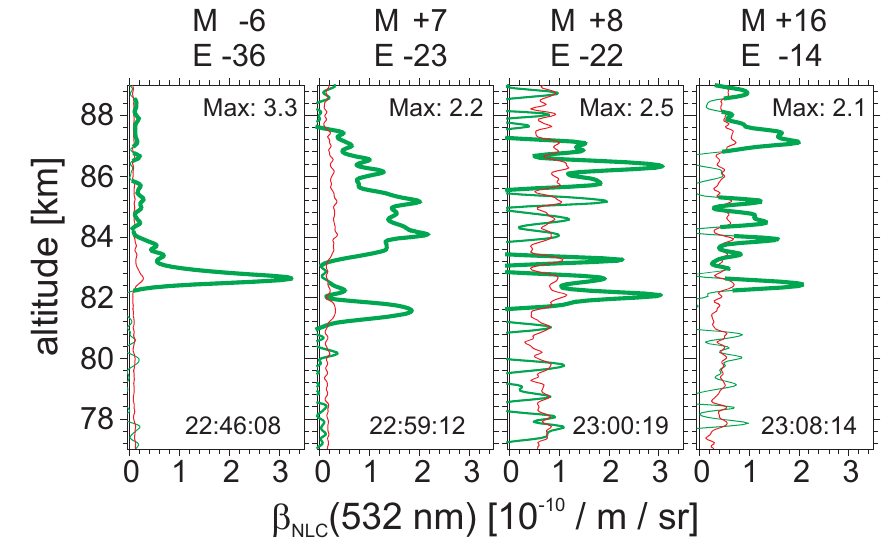
Fig. 7. Lidar back scatter ratio ∼ 20km north of ALOMAR around the time of MASS launch and prior to the ECOMA3 launch. The time in minutes relative to the MASS and ECOMA3 launch is indicated above the panels. Green lines show the measured backscatter coefficients, red lines are the error of the measurement calculated from the photon noise level. Thick green lines indicate the presence of NLC. The NLC display is very variable around the time of launch, which suggests inhomogeneities in the cloud. The statistics is limited due to insufficient clearings in the tropospheric